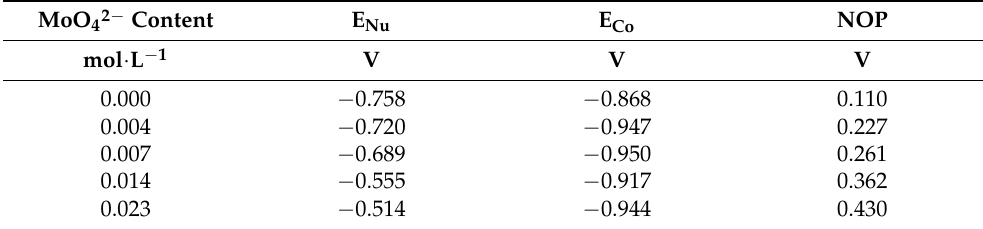
Table 2. The kinetic parameters for Co or Co-Mo electrodeposition in different electrolytes. MoO 42 −